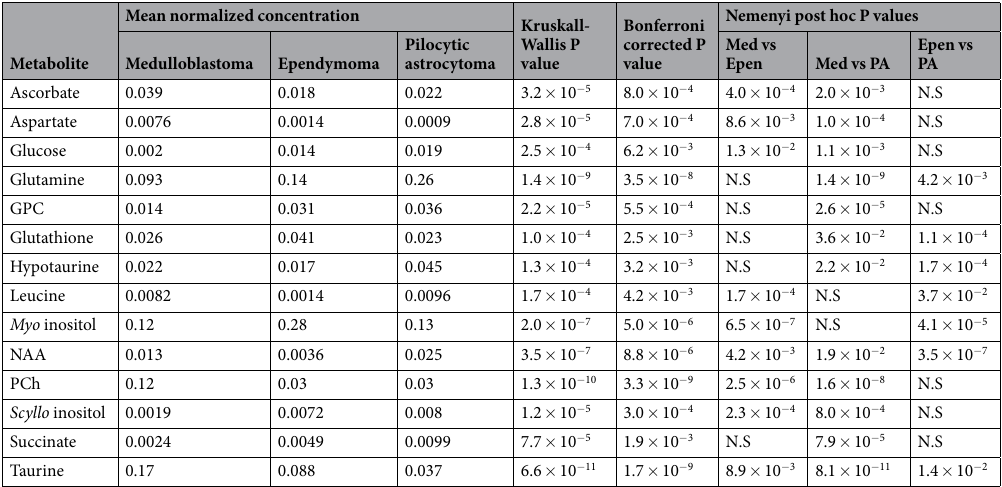
Table 1. Kruskal Wallis tests identify 14 metabolites with concentrations that vary according to diagnosis. Post hoc tests identify which tumors have significantly different metabolite concentrations. Abbreviations –